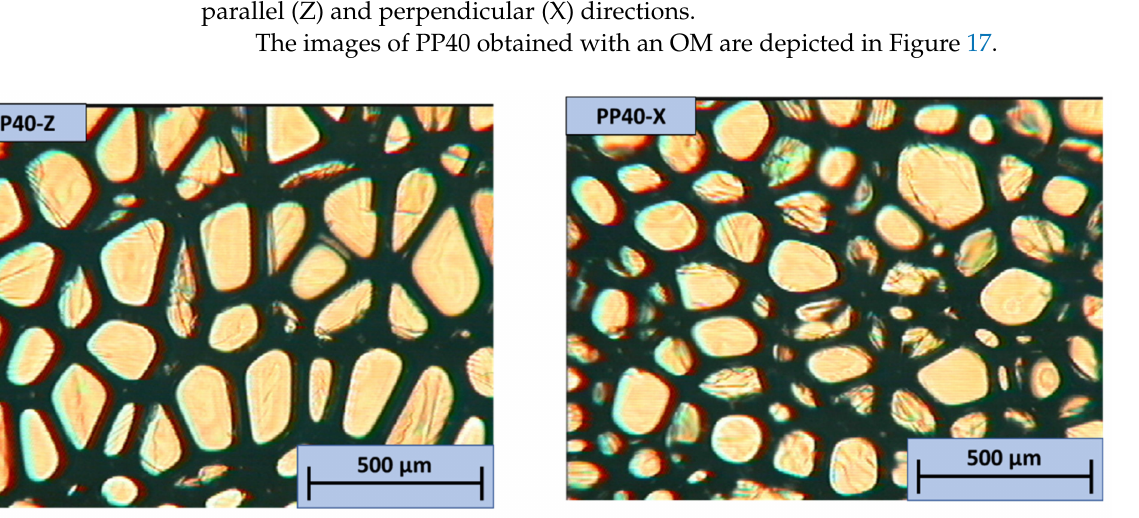
Figure 17. OM images of neat PP40 in both Z ( left ) and X ( right ) directions. Cells in the Z direction were more evenly distributed. The anisotropy index of neat PP40 in the Z direction was higher, which correlates with increased mechanical charac- teristics in the Z direction (compressive modulus and strength). In the X direction, few imperfections were observed. The images of neat PP40 and SiSD composites obtained with OM are depicted in Figure